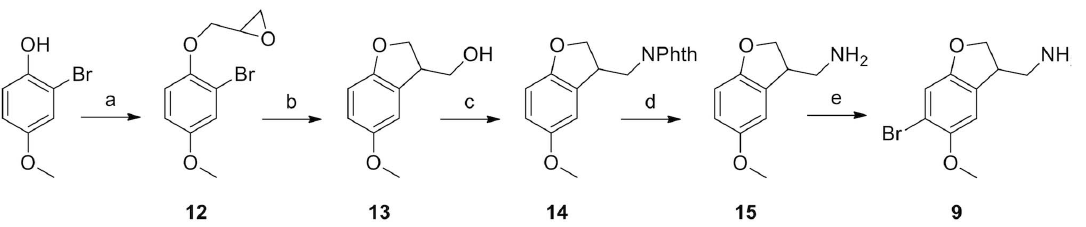
Figure 3. Synthesis of 9. Reagents and Conditions: (a) epichlorohydrin, Cs 2 CO 3 , MeCN, reflux, 4 h; (b) BuLi, THF, 2 78 u C to r.t., 30 min; (c) phthalimide, PPh